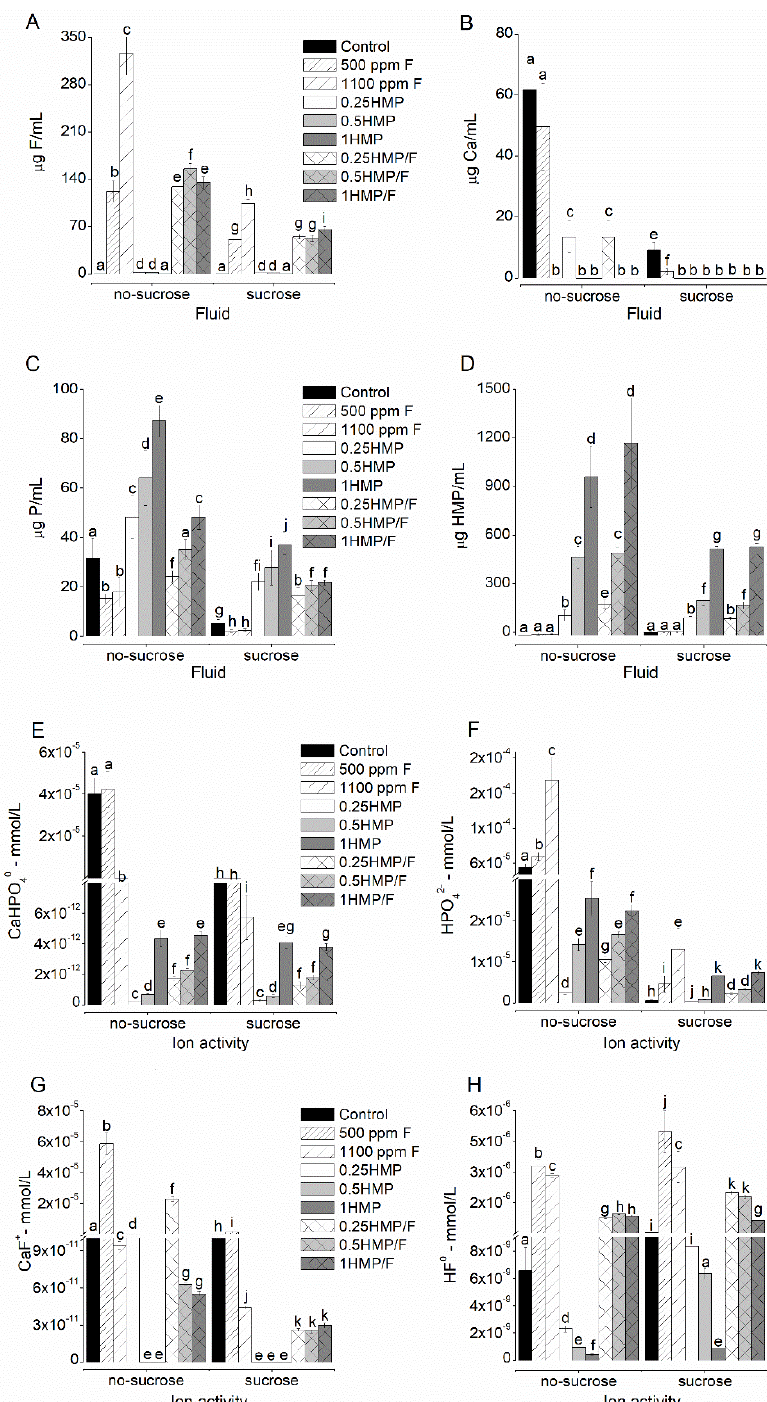
Figure 1. Mean values of F ( A ), Ca ( B ), P ( C ), and HMP ( D ), and ion activity of species CaHPO 40 ( E ), HPO 4 − 2 ( F ), CaF + ( G ), HF 0 ( H ) in the biofilm fluid, before and after exposure to sucrose. The order of the groups on the x-axis follows the legend sequence, with the control group presented in the solid black color. The letters indicate comparisons among all values in each graph. Values with distinct letters indicate that there is a statistical difference between them, and values with equal letters indicate that there are no statistical differences between them. Bars indicate standard deviation (two-way ANOVA and Fisher’s LSD test, p < 0.05). Each assay was run in triplicate in three different experiments ( n = 9).